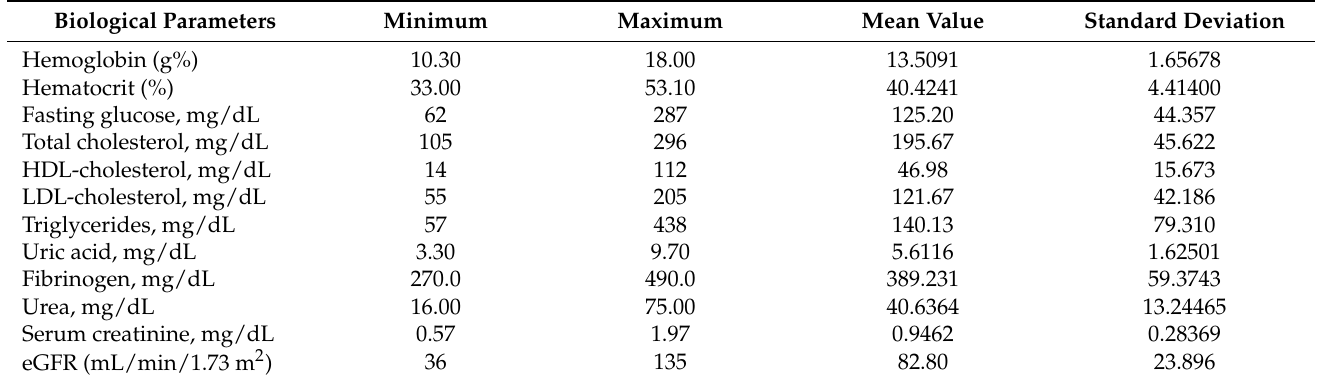
Table 2. Description of the analyzed biochemical and hematological parameters.